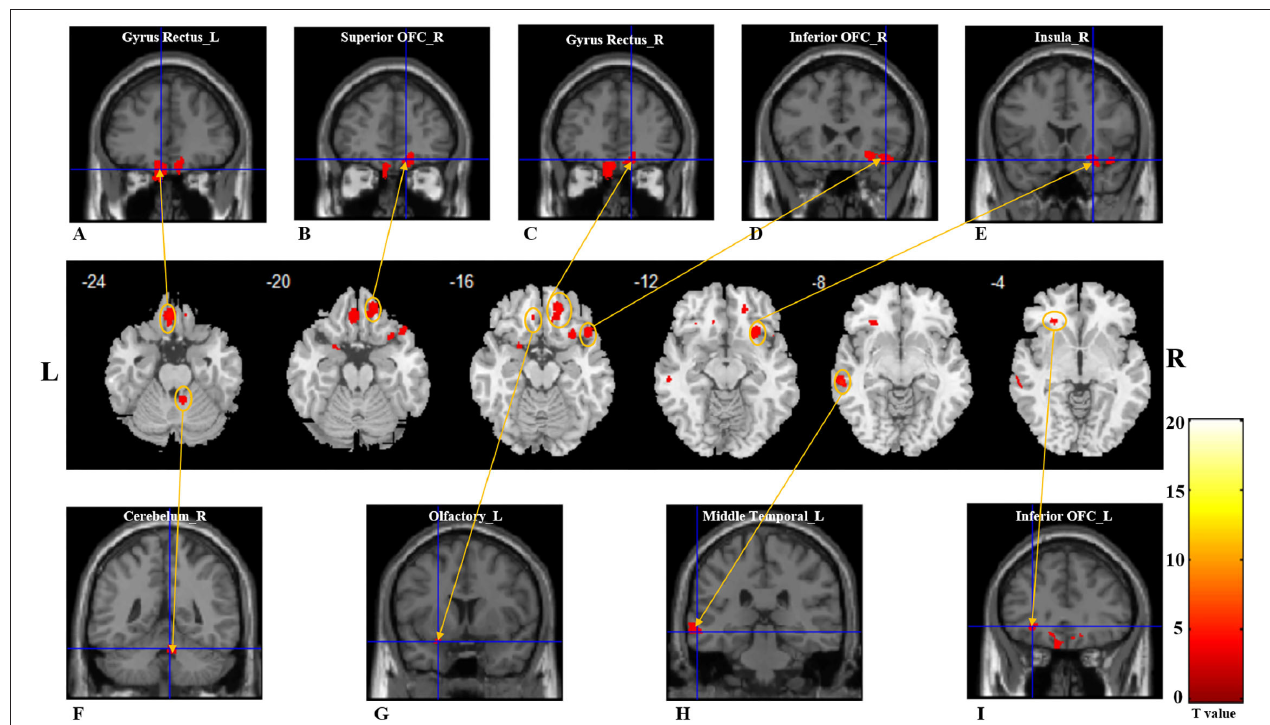
FIGURE 1 | Gray matter reductions in post-traumatic patients with anosima compared with healthy controls. The VBM result is thresholded at P < 0.001. Whole-brain analyses with P uncorrected < 0.001, and a cluster-extent threshold applied: k ≥ 36. (A–I) With red color represents the decreased GM volume regions in the patient group; (A) left gyrus rectus; (B) right superior OFC; (C) right gyrus rectus; (D) right inferior OFC; (E) right insula; (F) right cerebellum; (G) left olfactory cortex; (H) left middle OFC; (I) left inferior OFC. GM, gray matter; L, Left; R, Right; OFC, Orbitofrontal cortex.